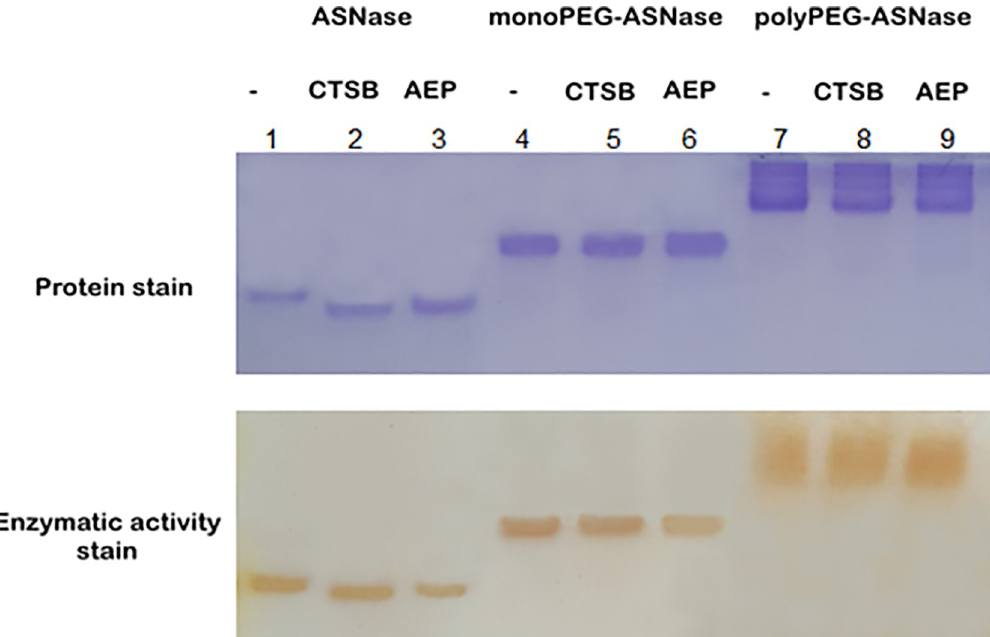
Fig 5. Electrophoresis gel (native-PAGE) showing the proteolytic degradation /resistance of native ASNase and PEGylated forms. ASNase, monoPEG-ASNase and polyPEG-ASNase in presence of asparagine endopeptidase (AEP) and cathepsin B (CTSB) after 84 h at 37˚C, stained with CBB (top gel) and stained with ferric chloride (bottom gel). Column 1- Protease-free ASNase, column 2- ASNase with CTSB, column 3- ASNase with AEP, column 4- protease-free monoPEG-ASNase, column 5- monoPEG-ASNase with CTSB, column 6- monoPEG-ASNase with AEP, 7- protease-free polyPEG-ASNase, column 8- polyPEG-ASNase with CTSB and column 9- polyPEG-ASNase with AEP.